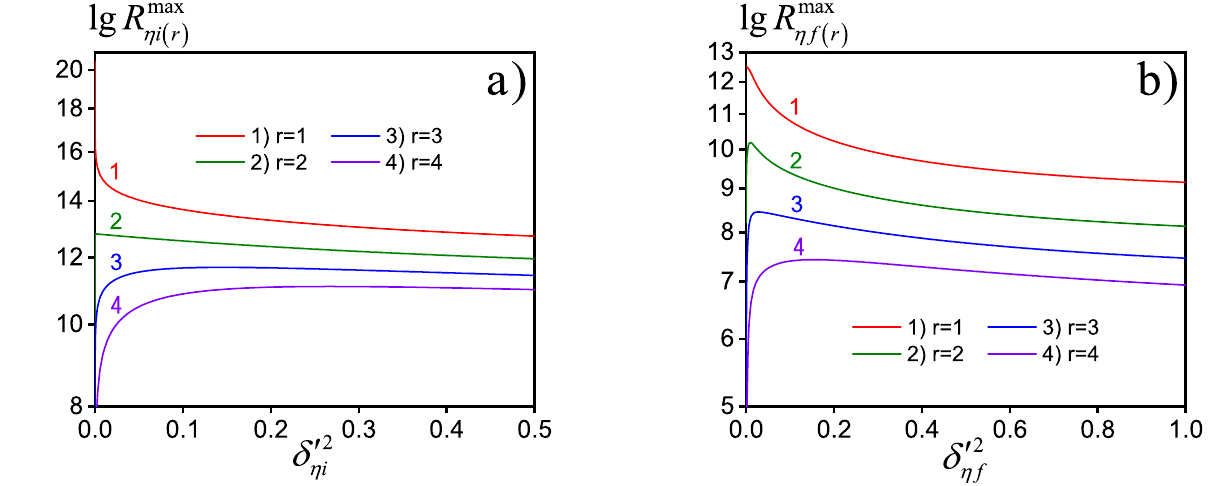
Figure 2. The maximum resonant di ff erential cross-section (in units of Z 2 α r 2 e ) as functions of the corresponding outgoing angles, plotted for the di ff erent values of absorbed wave photons. ( a ) R max η (21) for channel A. ( b ) R max η (22) for channel B. The frequency and intensity of the electromagnetic f ( r ) − 2 wave are ω = 0.2 keV and I = 0.746 × 10 23 Wcm . The energy of the initial electrons is E i = 65 GeV.